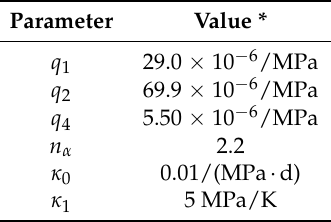
Table 4. Parameter values associated with creep and stiffness